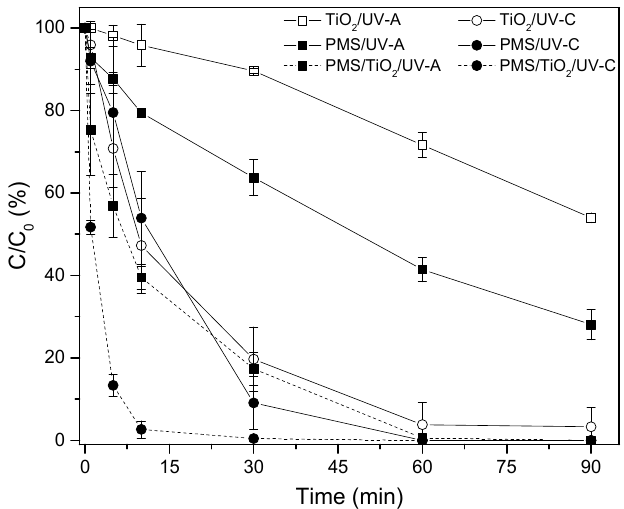
Figure 3. MB discoloration (%) through the PMS/TiO 2 system, under UV-A and UV-C radiation. [PMS] = 500 mg/L; [TiO 2 ] = 500 mg/L.